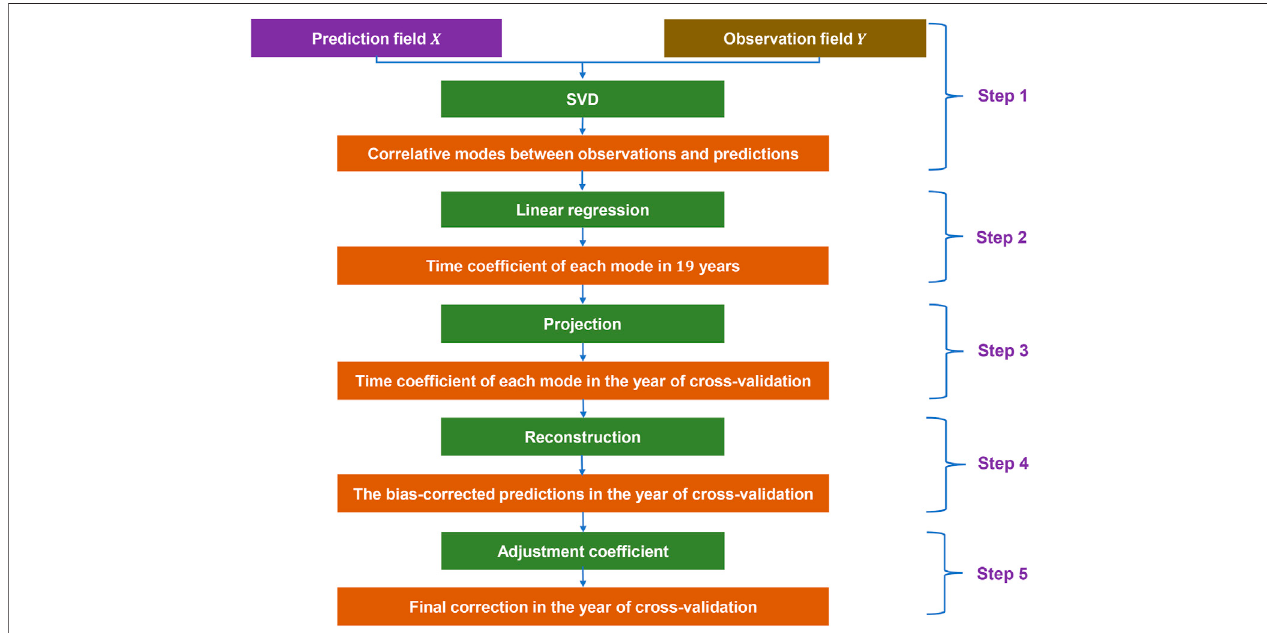
FIGURE 2 | Flowchart of the singular value decomposition (SVD) bias correction